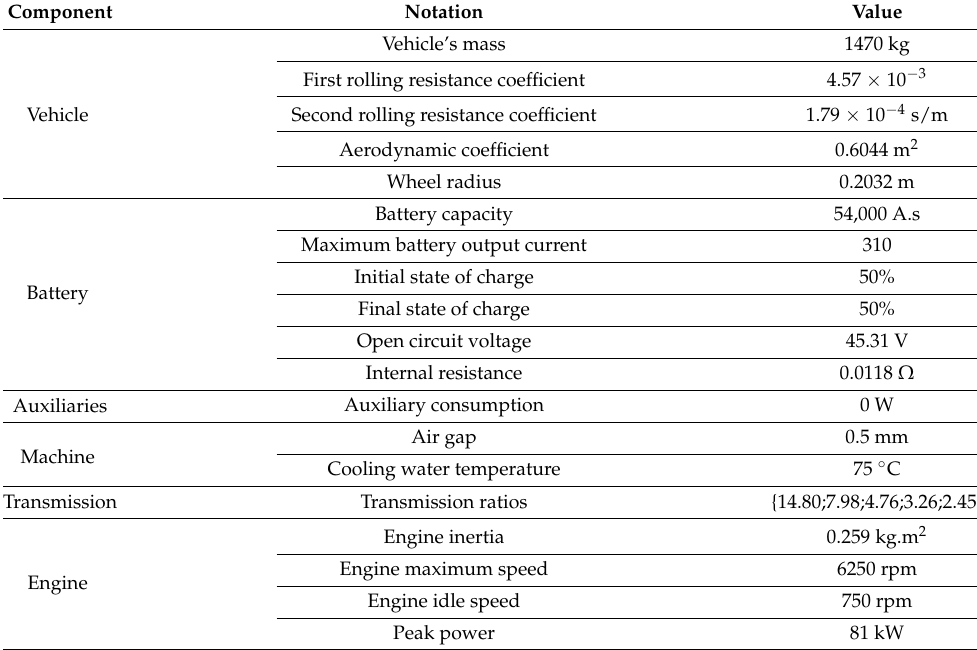
Table 3. Studied vehicle